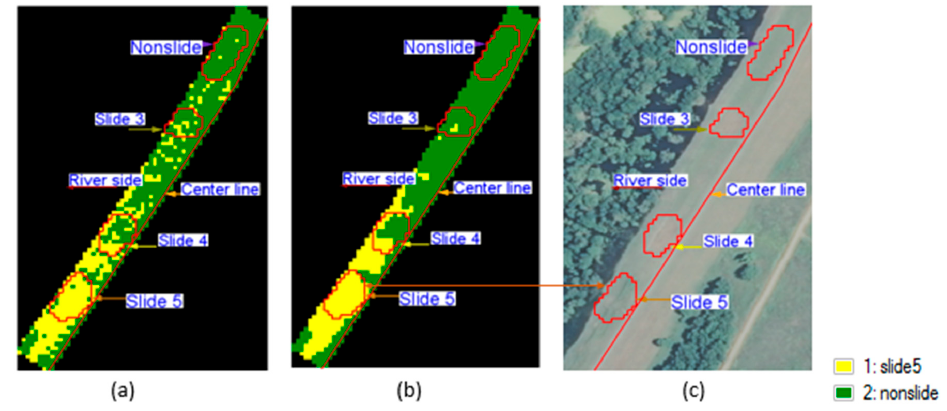
Figure 11. Complex data classification for the segment Sample 3: ( a ) without majority filter; ( b ) with majority filter; ( c ) optical image overlaid with slide and nonslide class shapes. J. Imaging 2016 , 8 , 26